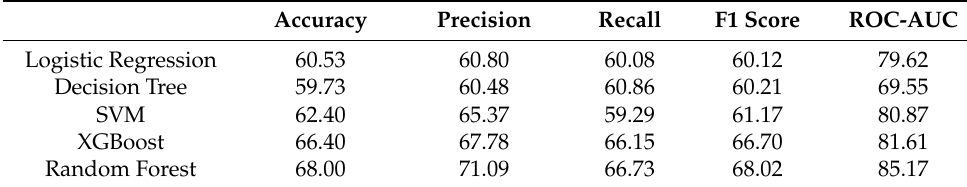
Table 2. Performance of models trained by various methods.